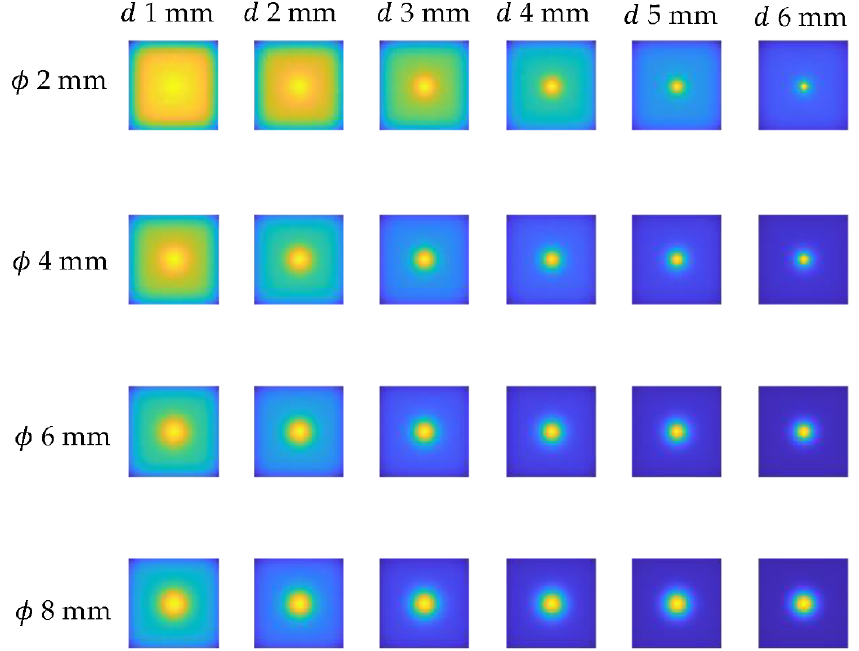
Figure 10. Exemplary numerical results for chosen defect diameter ( φ from 2 mm up to 8 mm) and depths ( d from 1 mm up to 6 mm).